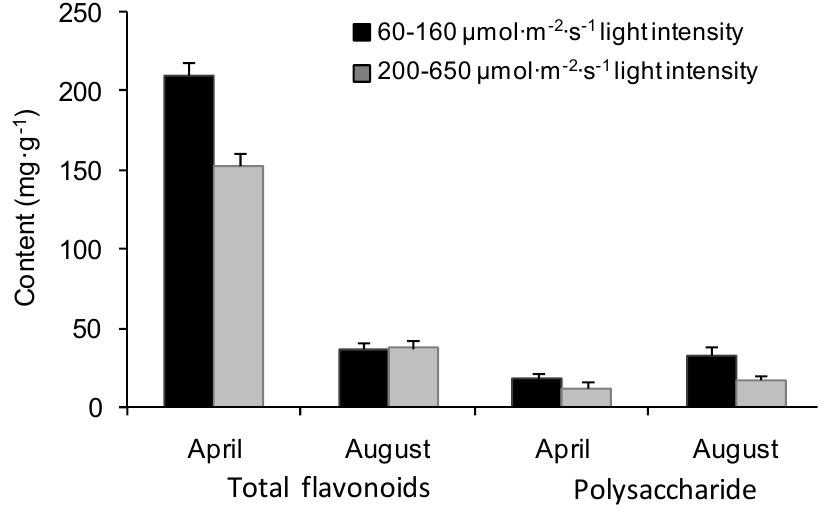
Figure 2. Contents of total flavonoids and polysaccharide influenced by different light intensities in the common garden experiment at Wuhan Botanical Garden. Bars are standard errors.